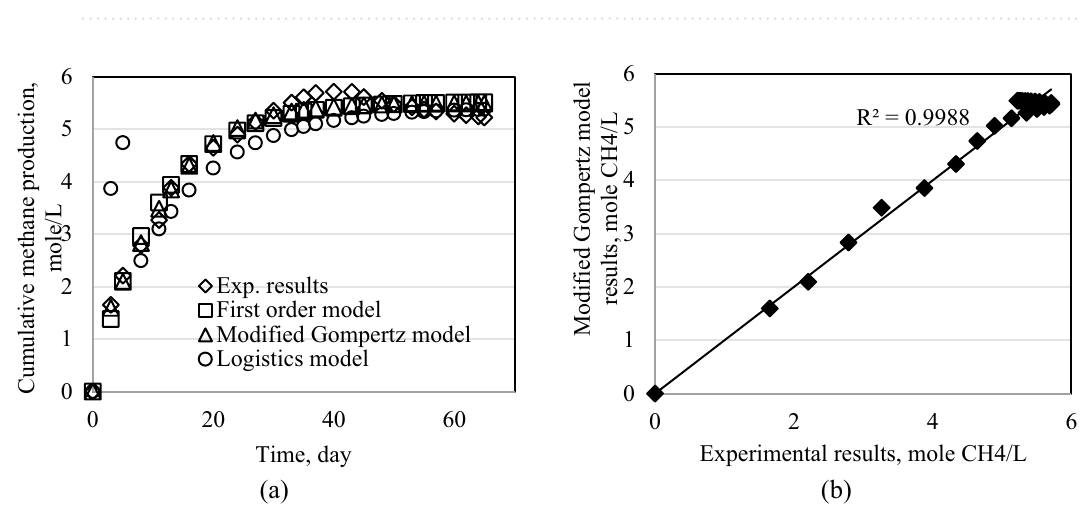
Figure 10. Results of models for Exp3. ( a ) Cumulative methane production for all models. ( b ) Modified Gompertz model